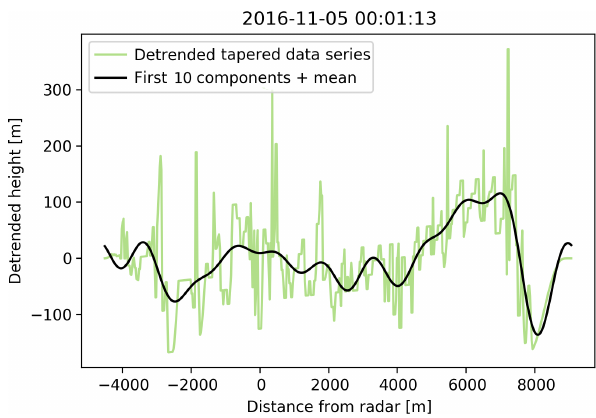
Figure 6. Original melting layer and the reconstituted melting layer from the first 10